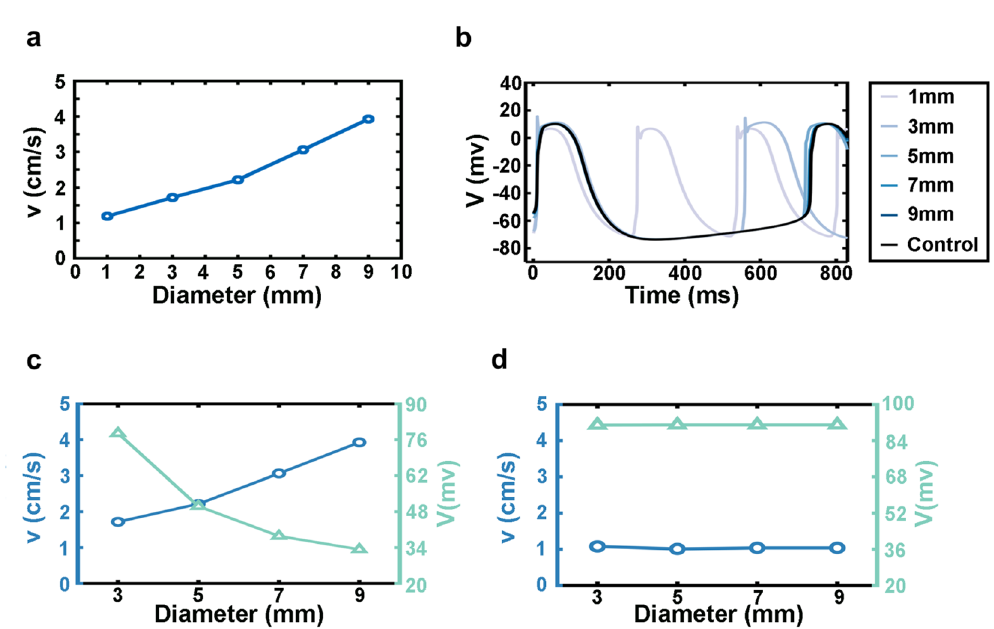
Figure 5. The relationship between the traveling wave speed and the membrane potential difference. ( a ) The relationship between the speed of 1 wave and the ring diameter in simulations. ( b ) Membrane potential curves of single-cell in rings maintaining 1 wave with different diameters. ( c ) Relationships among wave speeds, potential difference between neighboring cells just before activation, and ring diameters (blue: wave speed; green: potential difference). ( d ) Ring diameters does not affect the speed of 1 traveling wave when cells lose the hyperpolarization-activated current (blue: speed; green: potential difference). ( a – d :